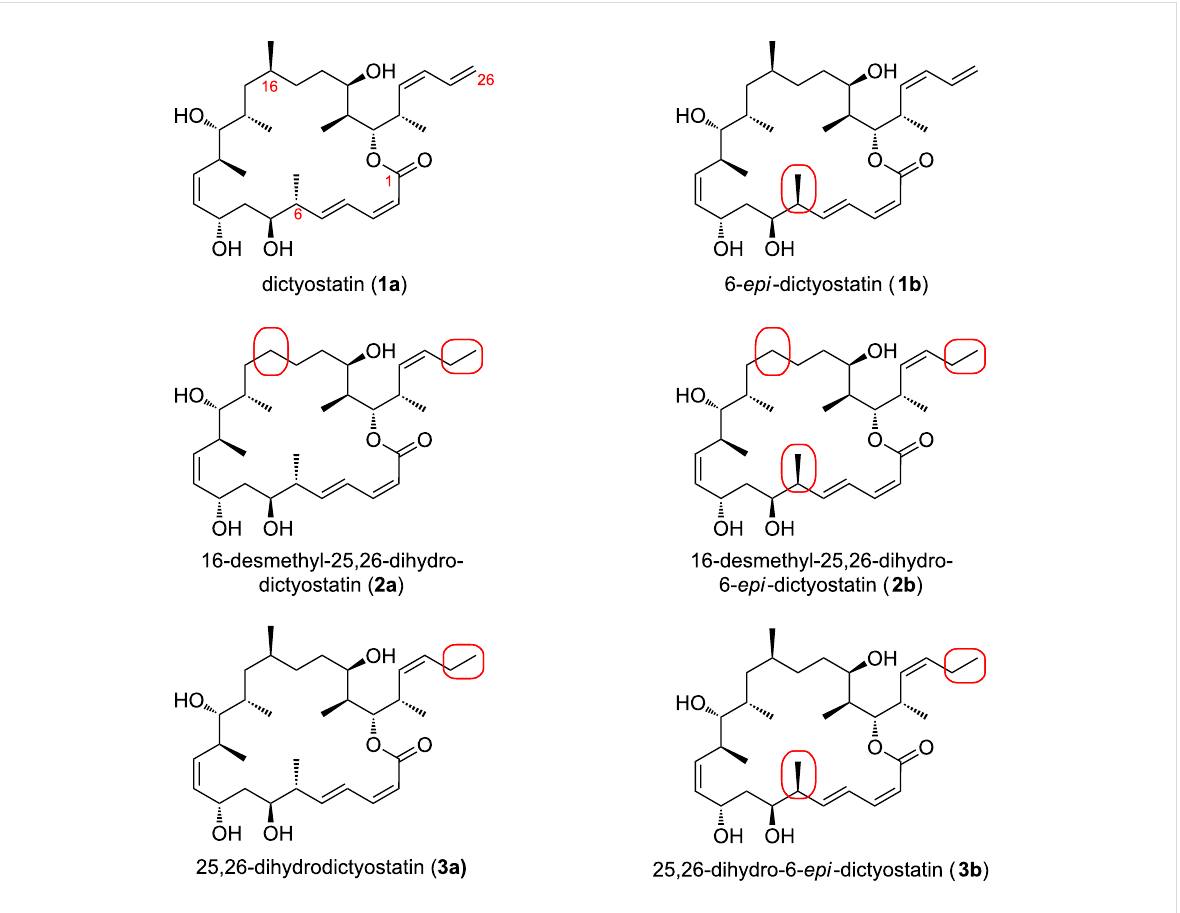
Figure 1: Structures of dictyostatin and selected analogs varying at C6, C16, and C25–C26.